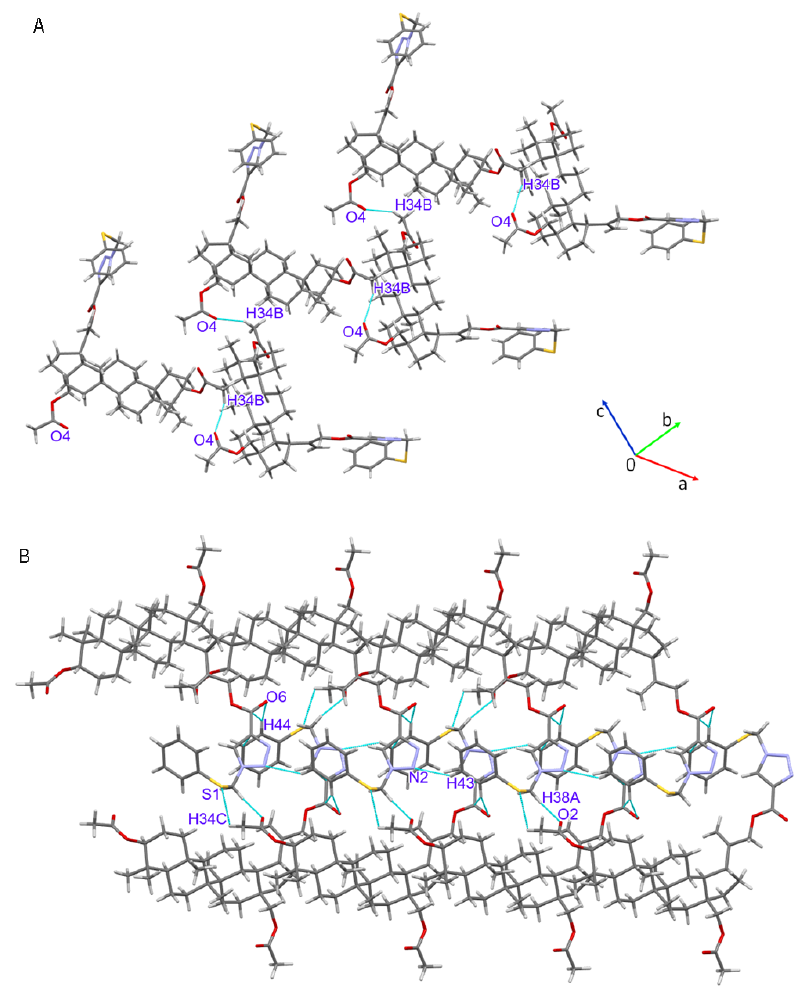
Figure 5. The intermolecular ( A ) hydrogen C34-H34B . . . O4 bonds and ( B ) the other hydrogen bonds and π – π interactions.